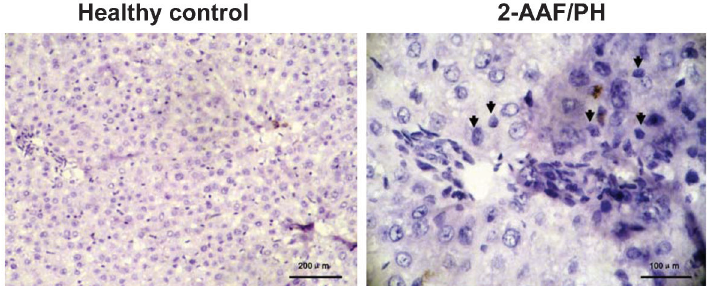
Figure 1. Hematoxylin & eosin staining of liver tissues. Liver tissues were obtained from healthy rats or rats that received 2-acetylaminofluorene (2-AAF)/partial hepatectomy (PH) for 8 days. Proliferating hepatic oval cells (HOCs) are indicated by